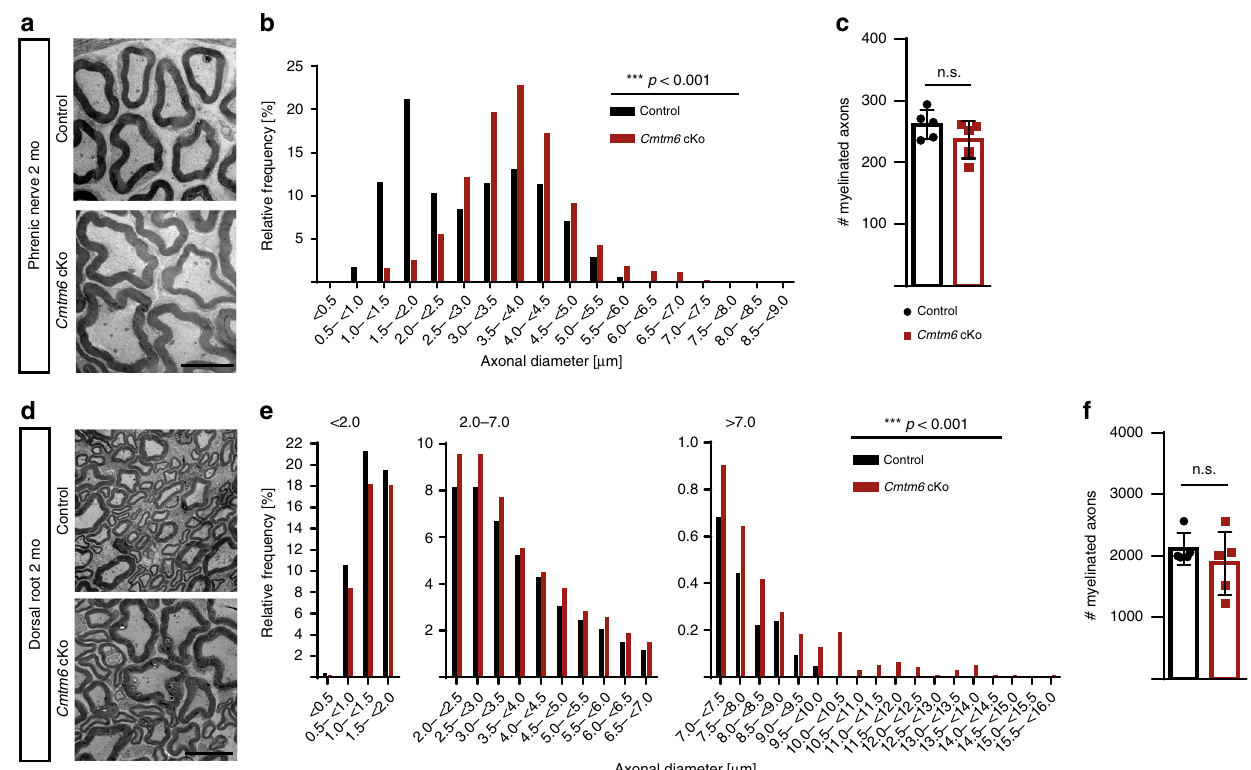
Fig. 2 Diameters of myelinated axons are abnormally increased when CMTM6 is lacking from Schwann cells. a Electron micrographs of cross-sectioned phrenic nerves reveal increased axonal diameters in Cmtm6- cKo compared to control mice at 2 months (2 mo). Scale bar, 5 µ m. b Genotype-dependent assessment of myelinated axons on semi-thin sections con fi rms shift towards larger axonal diameters in phrenic nerves of Cmtm6 -cKO compared to control mice. Data are presented as frequency distribution with 0.5 µ m bin width. n = 1293 axons from n = 5 control mice and n = 1172 axons from n = 5 Cmtm6 -cKO mice; Mean axonal diameter (control + / − Cmtm6-cKo ) = 2.87 µ m + 0.84 µ m; P = 2.2e − 16 by two-sided Kolmogorow – Smirnow test of frequency distributions. For sciatic nerves and tail nerves, Supplementary Fig. 5 ; g -ratios Supplementary Fig. 6 ; nodal parameters Supplementary Fig. 7; neuro fi lament density Supplementary Fig. 8 ; tamoxifen-induced deletion in adult mice Fig. 4. c Genotype-dependent quanti fi cation on semi-thin sections shows unchanged number of myelinated axons in the phrenic nerves of Cmtm6 -cKo-mice. n = 5 mice per genotype; P = 0.1929 by two-tailed Student ’ s t -test. d Representative electron micrographs of cross-sectioned dorsal roots show increased axonal diameters in Cmtm6- cKo compared to control mice at 2 mo. Scale bar 5 µ m. e Genotype-dependent assessment of the diameters of myelinated axons on semi-thin sections con fi rms the shift towards larger axonal diameters in dorsal roots of Cmtm6 -cKO-mice. Data are presented as frequency distribution with 0.5 µ m bin width, n = 10387 axons from n = 5 control mice and n = 9298 axons from n = 5 Cmtm6 -cKO mice; mean axonal diameter (control + / − Cmtm6-cKo ) = 2.47 µ m + 0.27 µ m; P = 2.2e − 16 by two- sided Kolmogorow – Smirnow test of frequency distributions. f Genotype-dependent quanti fi cation on semi-thin sections shows unchanged numbers of myelinated axons in the dorsal root of Cmtm6 -cKo-mice. n = 5 mice per genotype; P = 0.3894 by two-tailed Student ’ s t -test. Data in c and f presented as mean ± SD. n.s. = non-signi fi cant P > 0.05; *** P < 0.001. Source data see Source Data fi le.